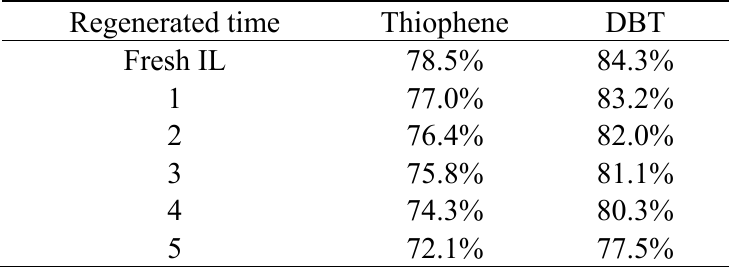
Table 2. The desulfurization of model oil by regenerated